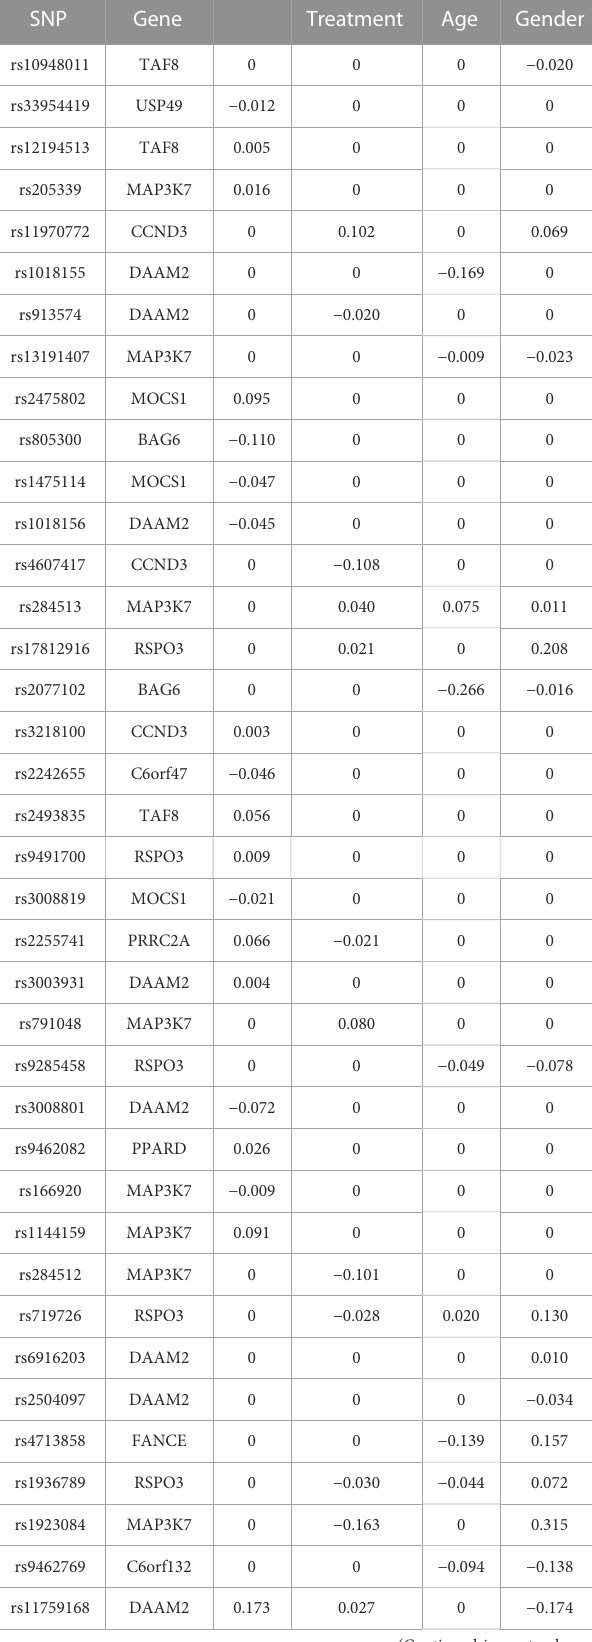
TABLE 1 Identi fi ed main and interaction effects based on the genes from the Wnt signaling pathway on chromosome 6.